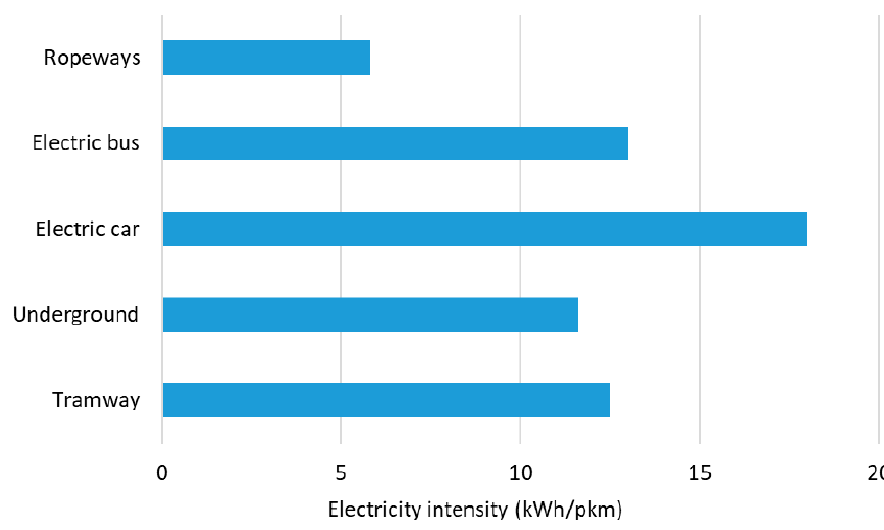
Figure 14. Electricity intensity of various modes of e-mobility in cities (Data source: [64], own anal-